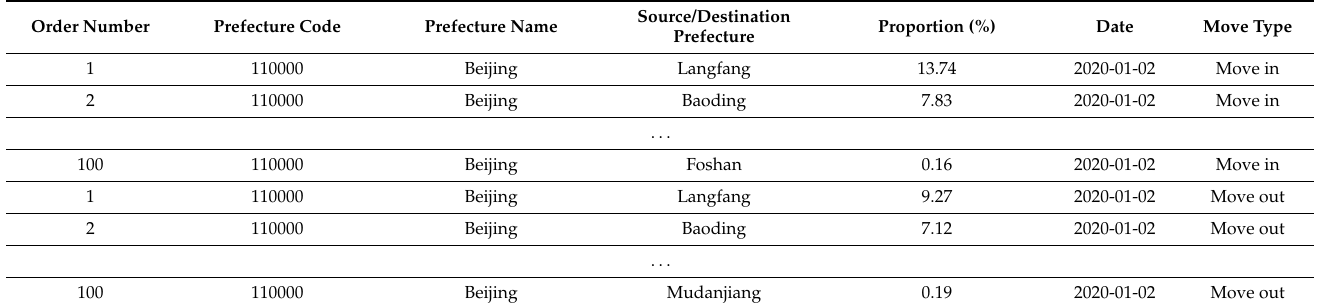
Table A1. Example table of the migration proportion data.